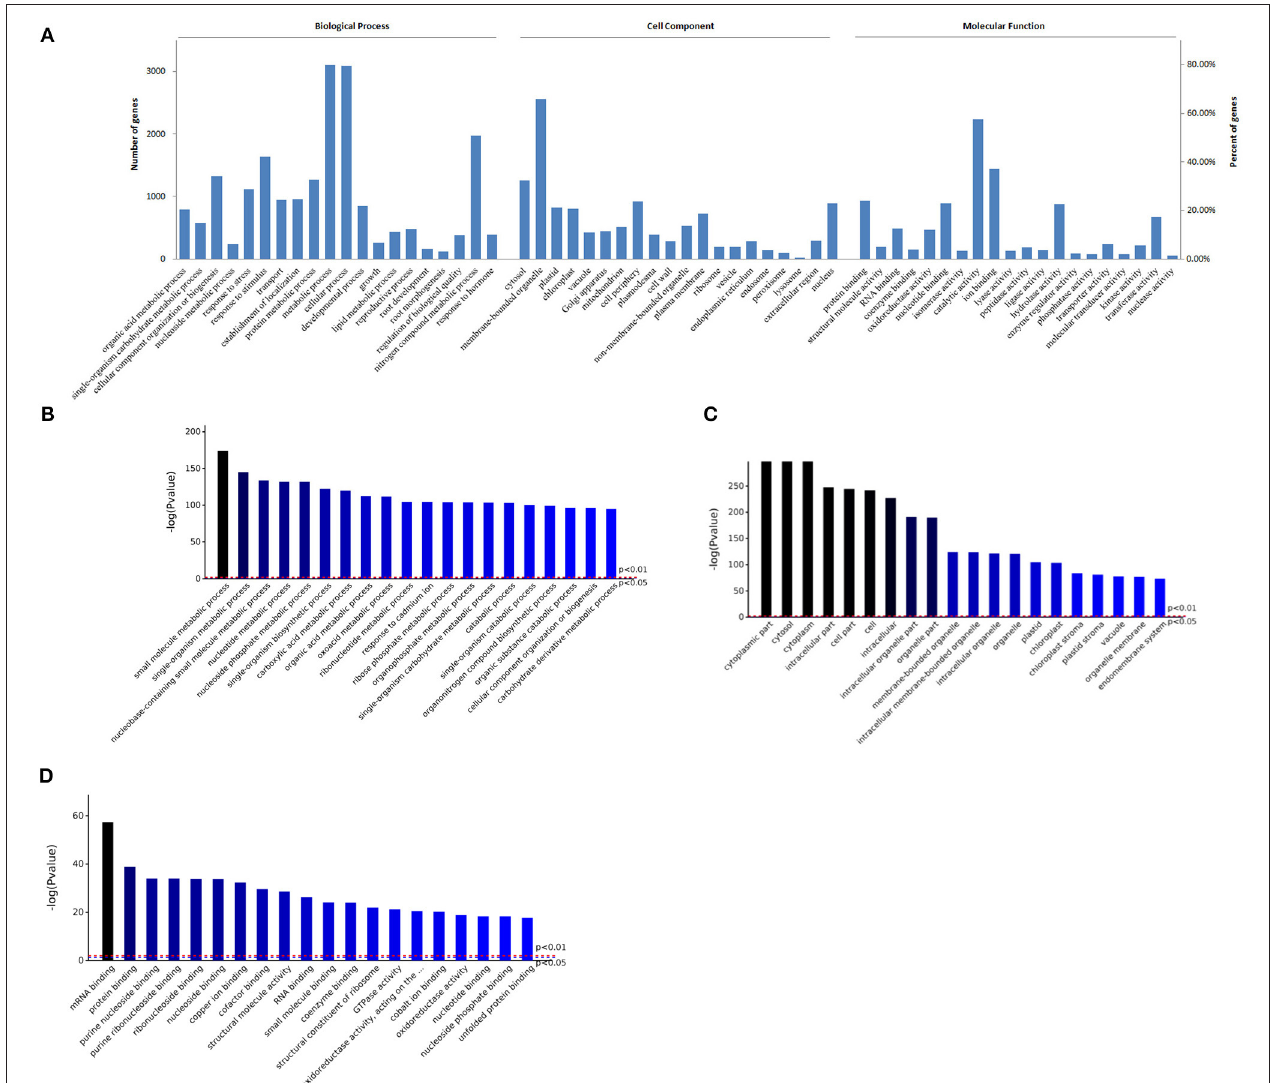
FIGURE 1 | GO enrichment analysis of proteins in roots of R. glutinosa. (A) GO distribution of proteins, the abscissa represents the entries in each category (Biological Process, Cell Component, Molecular Function), the left and right ordinate represent the number or percent of proteins which are included in each entry. (B–D) Represents the top 20 entries in BP, CC, or MF enrichment results, respectively, the abscissa represents the entries, P value of red line and blue line is respectively 0.01 or